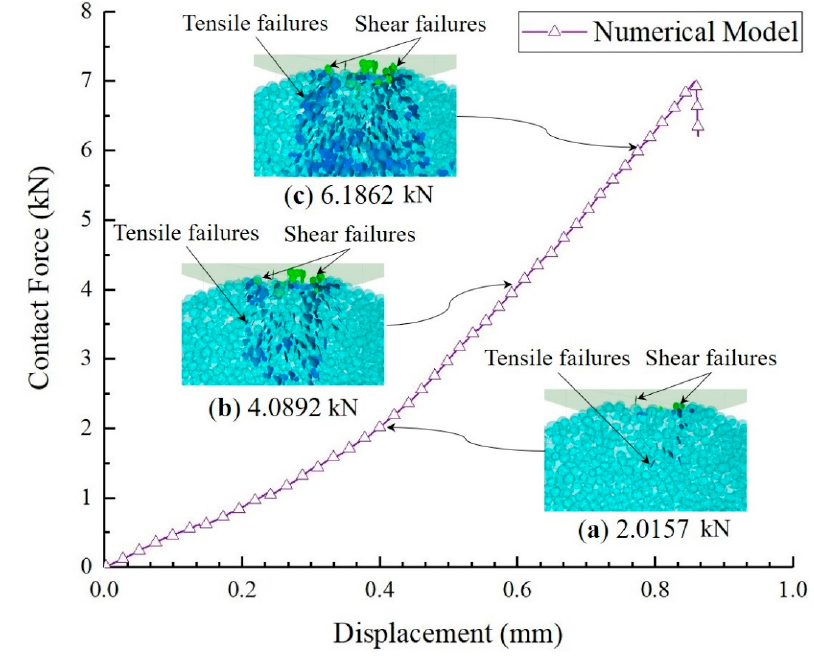
Figure 16. Bond state at different loading stages: ( a ) 2.0157 kN; ( b ) 4.0892 kN; and ( c ) 6.1862 kN.